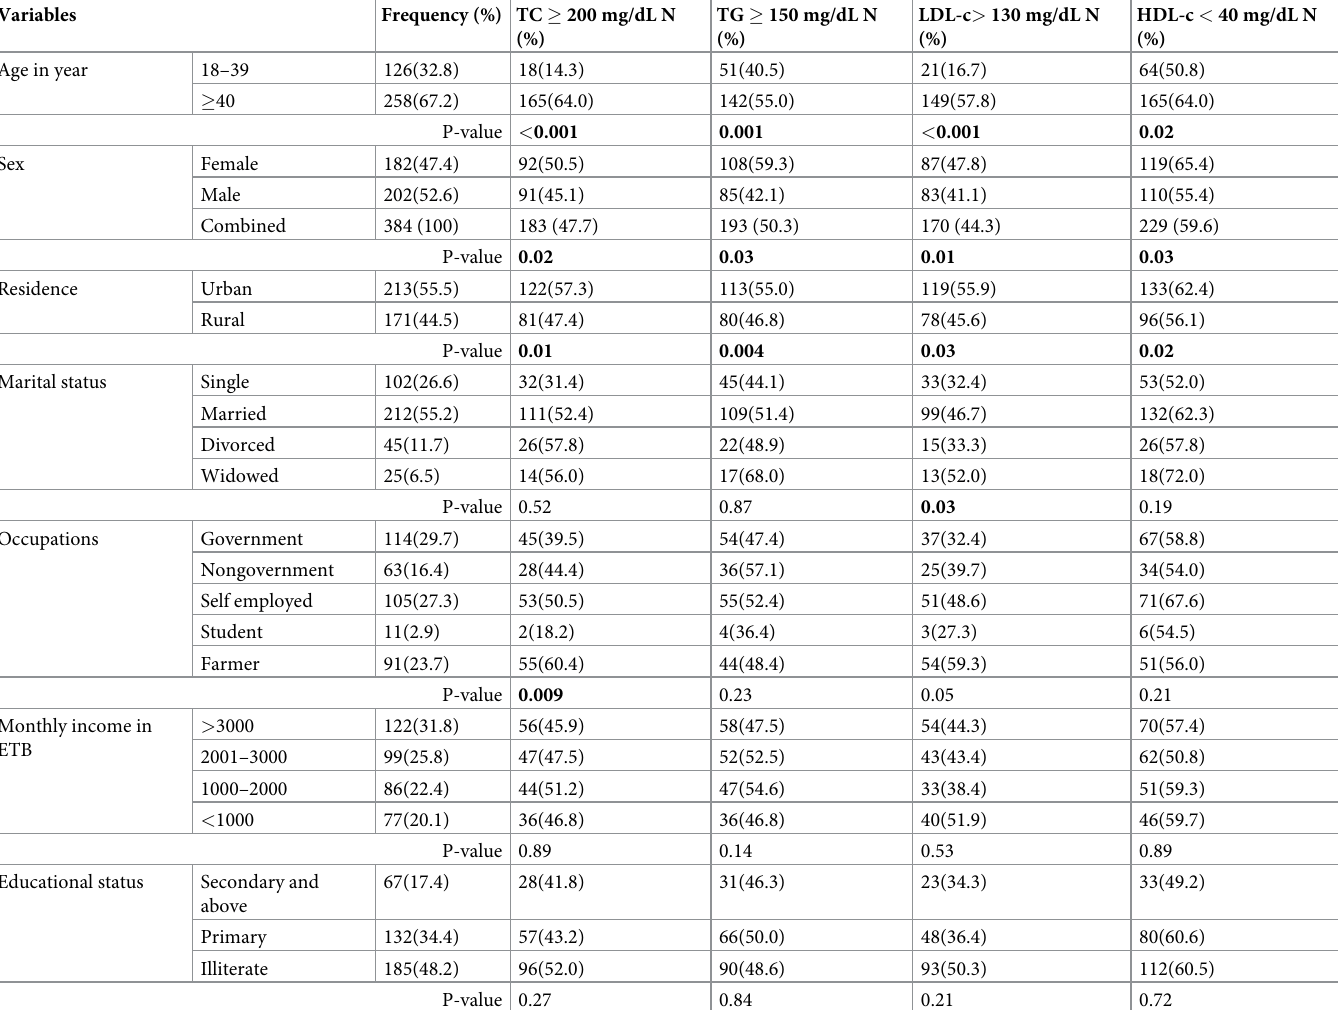
Table 1. Distribution of dyslipidemia by socio-demographic characteristics of hypertensive patients in Northeast Ethiopia, 2021 (n = 384).